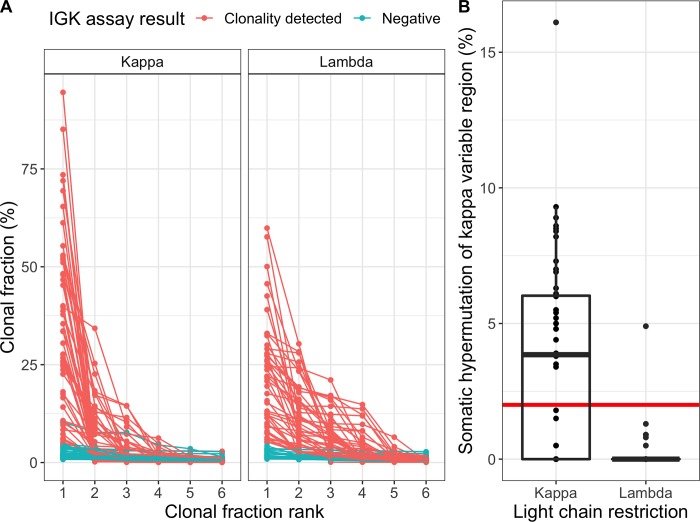
More IGK rearrangements and minimal somatic hypermutation of clonal VK-sequences in lambda-restricted multiple myeloma.A: Clonal fractions of the six most abundant IGK rearrangements in kappa-restricted cases are shown to the left; lambda-restricted to the right. Lines connect rearrangements derived from the same sample. Samples are colored red where the most abundant rearrangement was defined as clonal by the analysis software. Samples where no clonal rearrangement could be identified (teal) are shown to give an impression of the polyclonal background. Lambda-restricted cases show evidence of more clonal sequences compared with kappa-restricted. B: SHM of the most abundant clonal rearrangements involving the VK region in kappa-restricted and lambda-restricted cases, measured as % change from the germline sequence. The red horizontal line at 2% represents the commonly used cut-off between sequences considered non-mutated (below) as compared with significantly mutated (above).